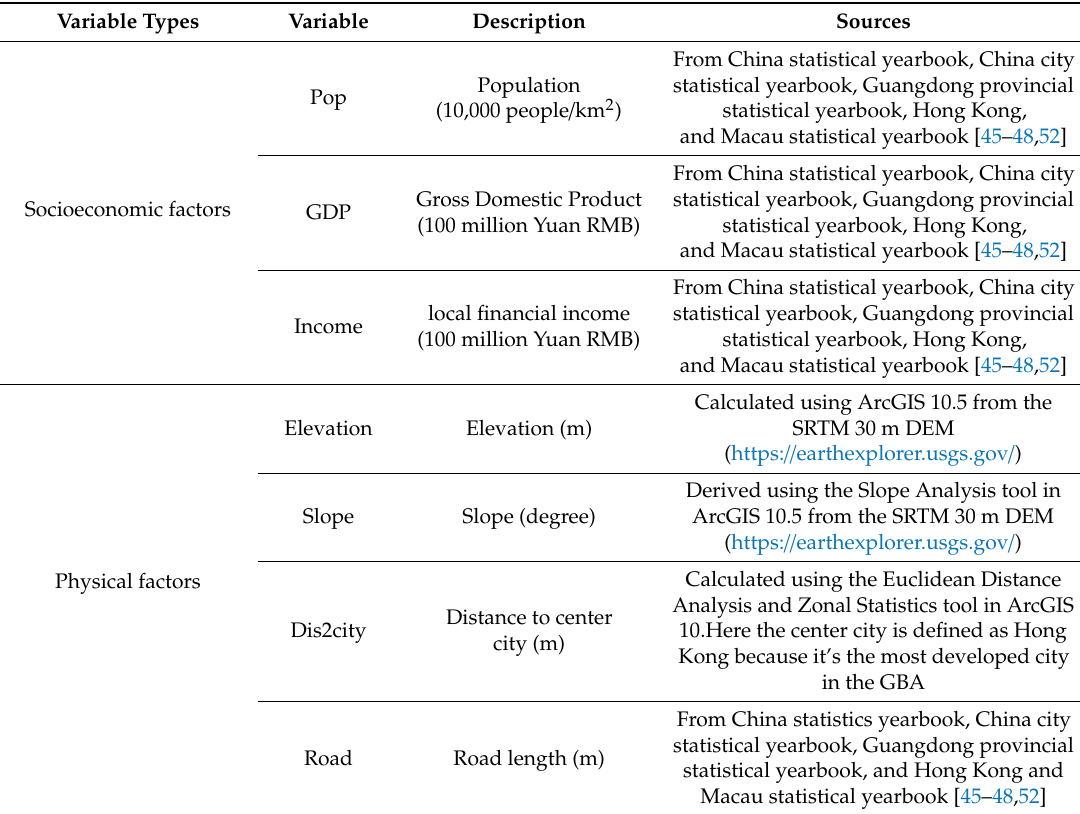
Table 2. Variables used to study the driving factors of urban